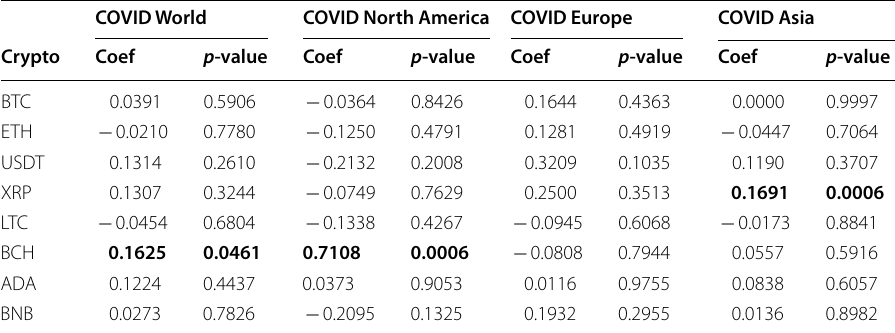
Table 2 CC daily trading volume variations models are explained by the variation in the effective reproductive